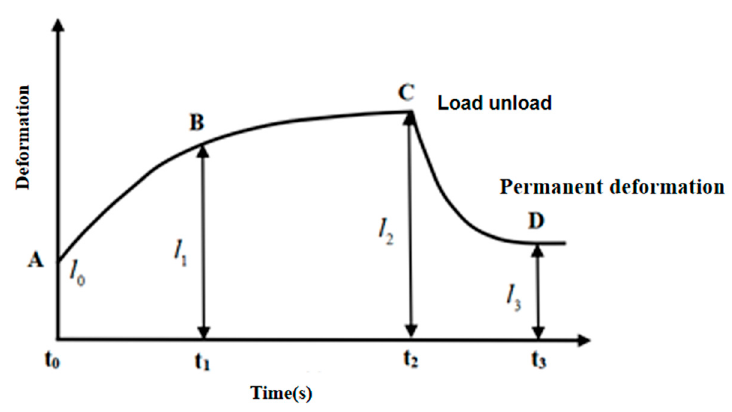
Figure 1. Creep process of rubber.